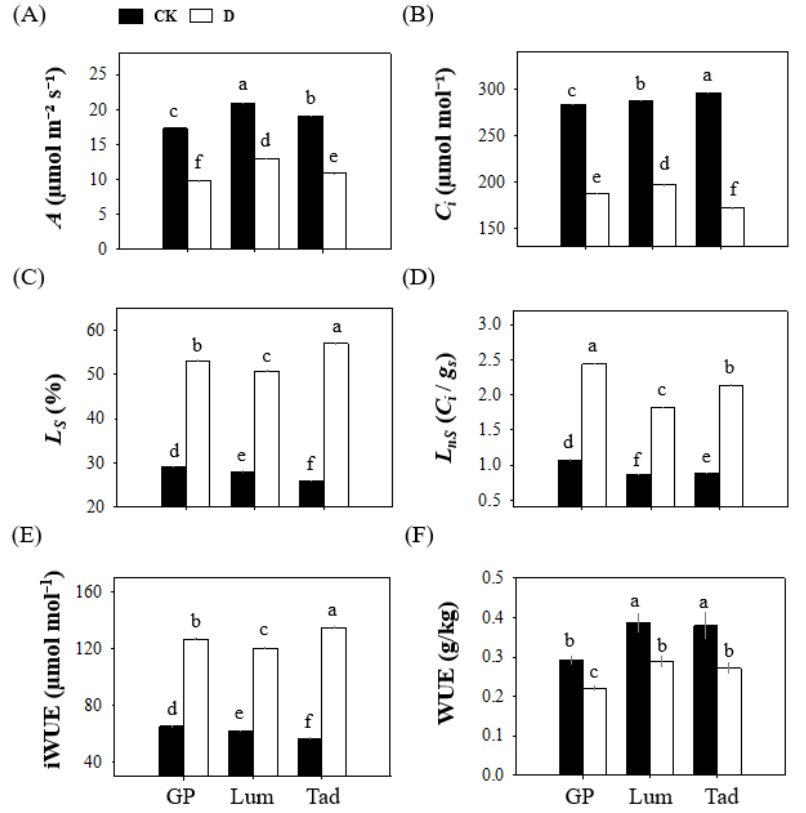
Figure 3. Photosynthetic parameters for GP, Lum, and Tad. Steady-state A ( A ), C i ( B ), L S ( C ), L nS ( D ), and iWUE ( E ) measured at a temperature of 25 °C, RH of 60%, 1400 μmol m −2 s −1 PAR, and 400 μmol mol –1 C a . L S = 1 − C i / C a ; L nS = C i / g s ; iWUE = A / g s . ( F ) WUE = dry weight (g)/water consumption (kg). Data are presented as the means ± se ( n = 3–4). Different letters above the error bars indicate significant differences at p < 0.05.